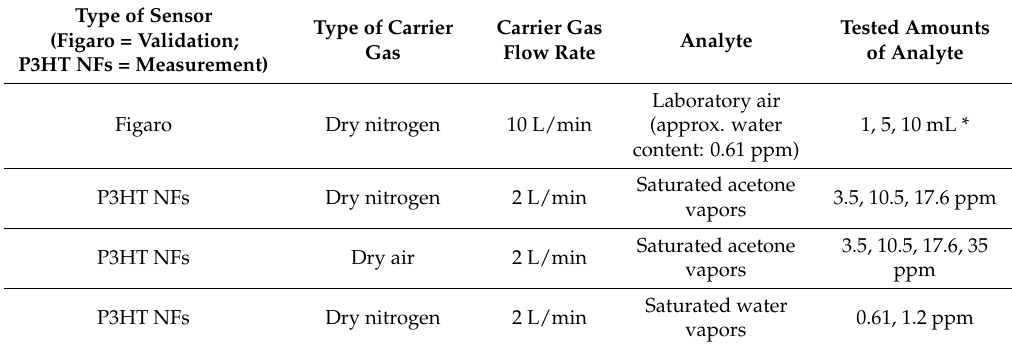
Table 1. Summary of the different conditions used for the described